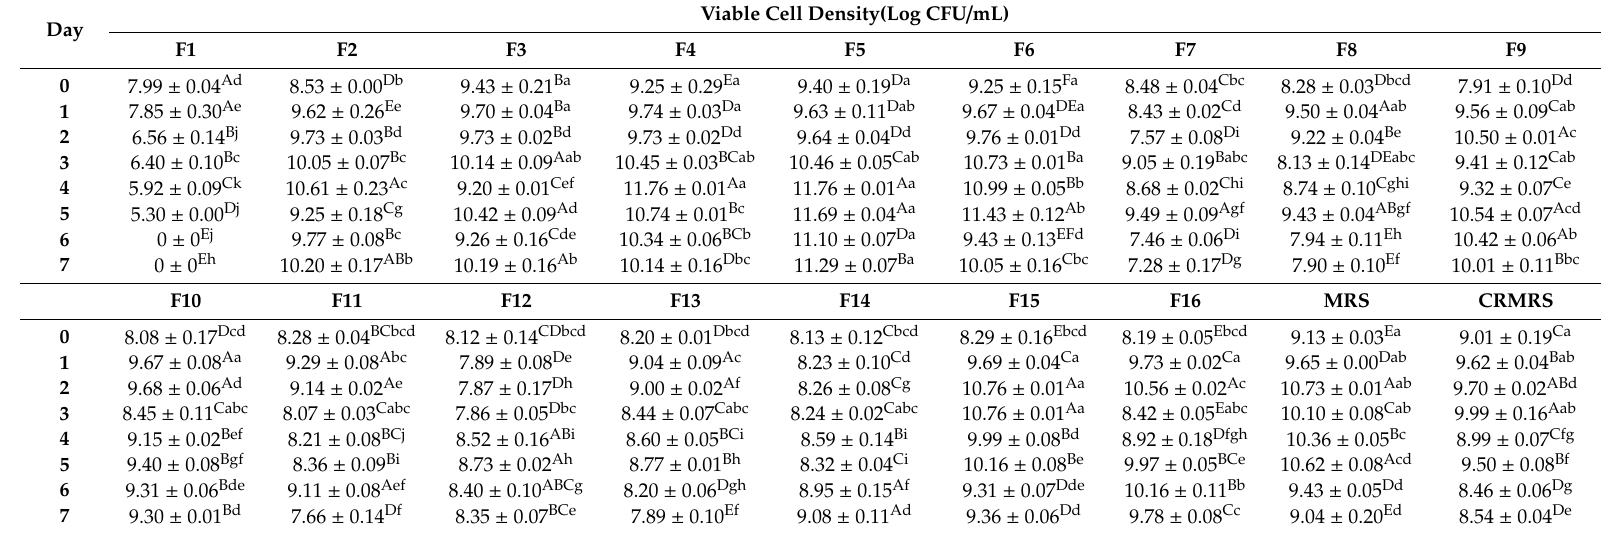
Table 1. Viable cell count of Lactobacillus plantarum RI 11 grown in media designed by